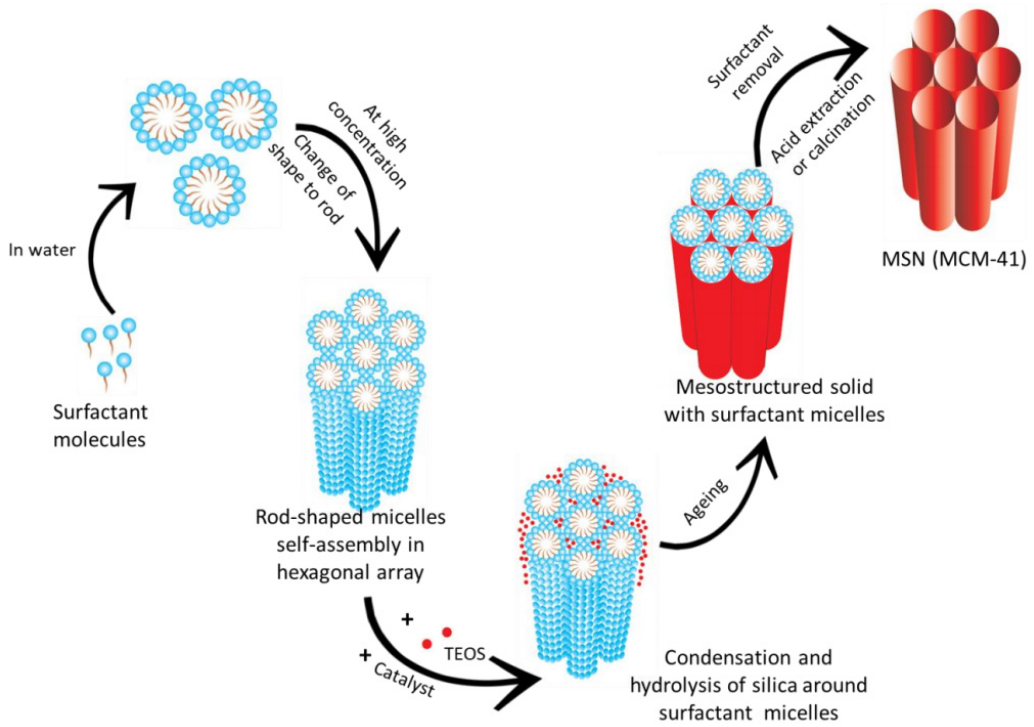
Figure 2. Mechanism of formation of MCM-41. Reproduced with permission from Ref. [63], Copy- right 2018, MDPI.